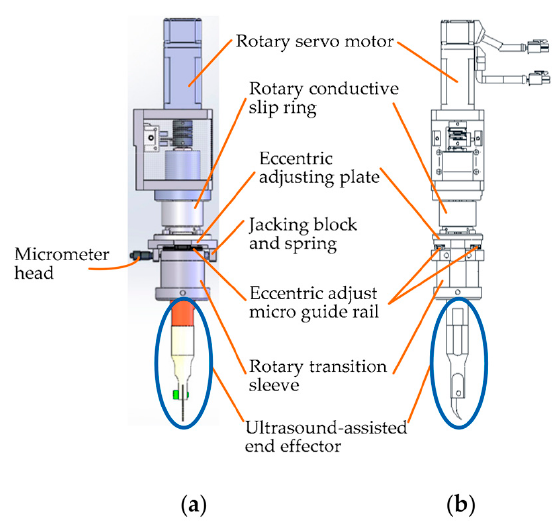
Figure 11. Design details of the eccentric adjusting mechanism. ( a ) Front view. ( b ) Side view.